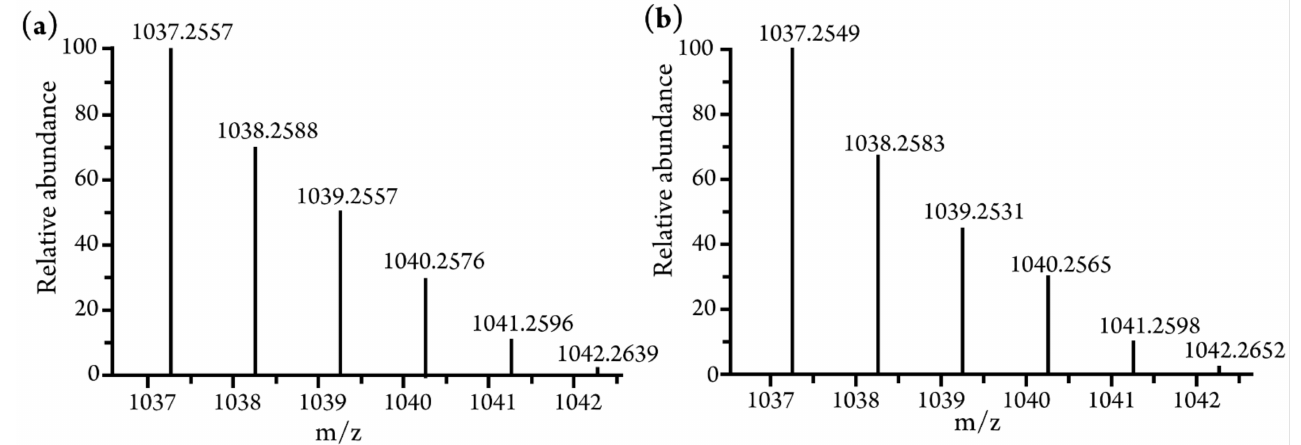
Figure 6. Isotopic distribution pattern of the ( a ) experimental, and ( b ) simulated ESI-MS spectra of [(TPP)Mn–O–Cu(tmpa)+H] + . The sample was prepared in MeTHF and recorded in positive-ion mode with a source voltage of 1.0